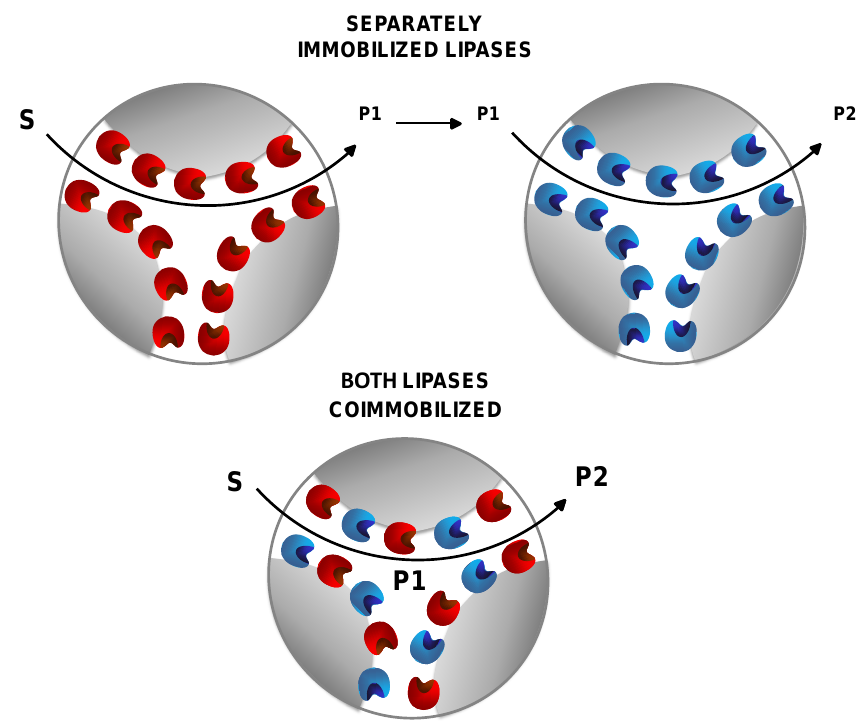
Figure 22. Schematic representation of the use of coimmobilized and independently immobilized enzymes in a cascade reaction.